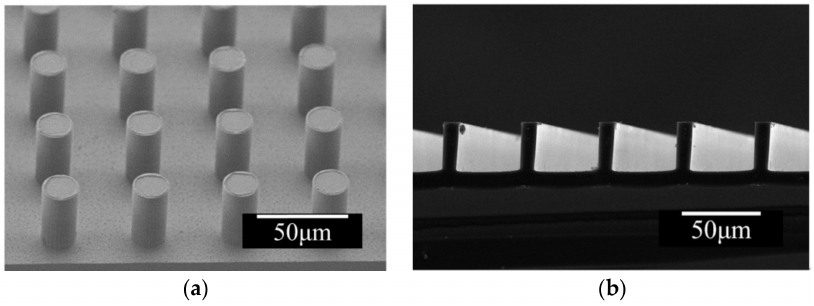
Figure 3. SEM images of microstructured silicon molds. ( a ) Micropillars; ( b )